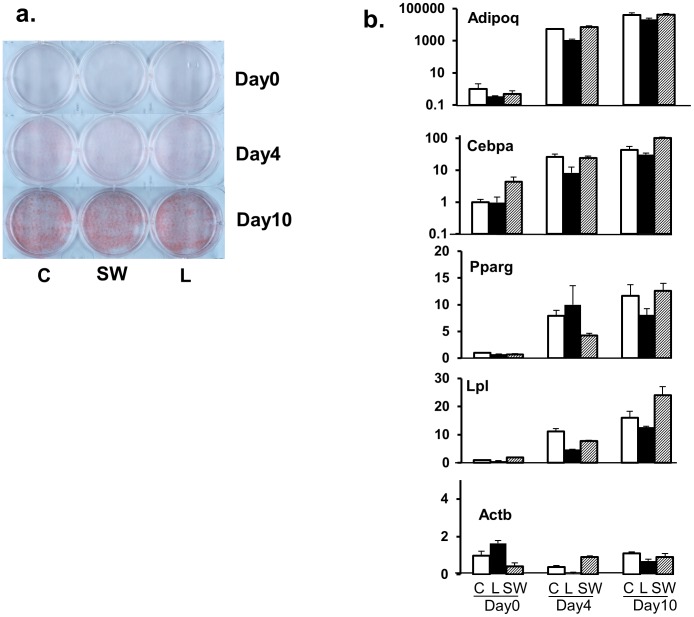
Effects of leucine supplementation and serum withdrawal on 3T3-L1 adipocyte differentiation.
a. Oil-red O staining of cell cultures at Day 0, Day 4 and Day 10 under control, leucine or serum withdrawal conditions. Cells were grown under the defined conditions for the specified periods of time and stained for total neutral lipids. b. Quantitative PCR analysis of key genes associated with adipocyte differentiation. Gene names are indicated on the plots. Gene expression abundances were estimated by the ΔΔQ method after normalizing to GAPDH and referencing to Control, Day 0 samples. Due to the relatively high range of fold-change for adiponectin and CEBP-alpha, their relative abundances are expressed in the log10 scale. The treatments and stages of differentiation are indicated at the bottom (C,control; L, leucine; SW, serum-withdrawal).